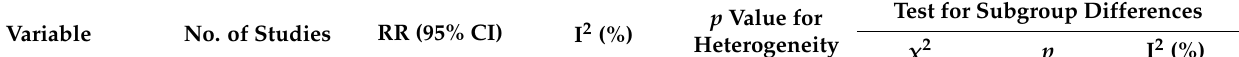
Table 2. Subgroup analyses for the association between maternal BMI and risk of cancer in